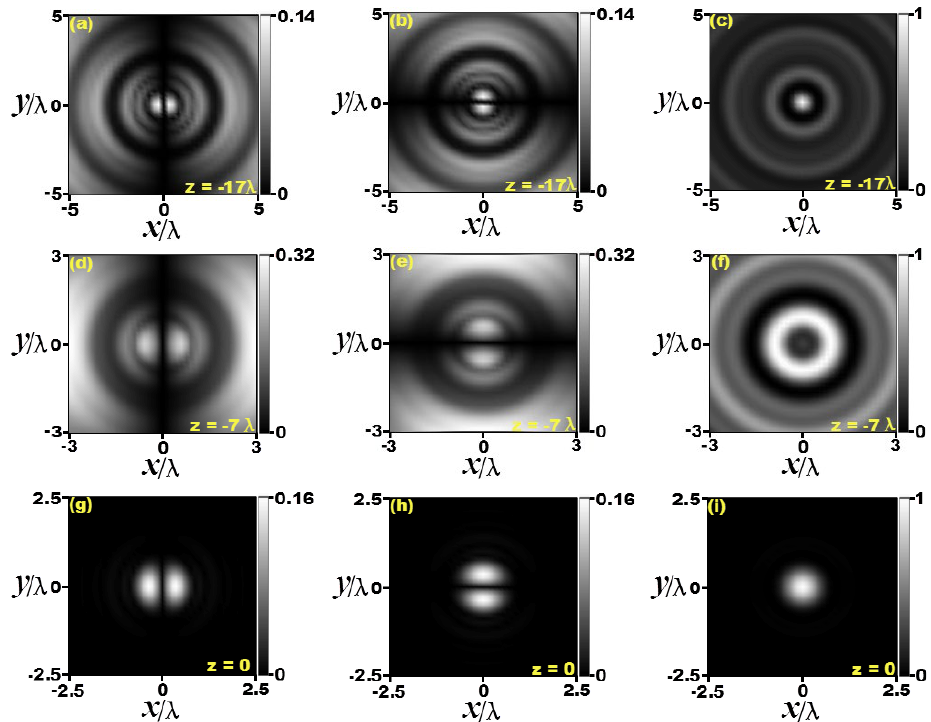
Figure 8. Poynting vector distributions in different cross sections around the focus. ( a ), ( d ), ( g ) are ( b , e , h ) are S y ; and ( c , f , i ) are S z . Parameters for calculation are chosen as λ = 633 nm, α = 3, NA = 0.9, S x ; ( b ), ( e ), ( h ) are S y ; and ( c ), ( f ), ( i ) are S z . Parameters for calculation are chosen as λ = 633 nm, α = f = 3.4 cm, µ = 10 mm − 2 , and E 0 = B 0 = 3, NA = 0.9, f = 3.4 cm, μ = 10 mm ₋ 2 , and E 0 = B 0 = 1.